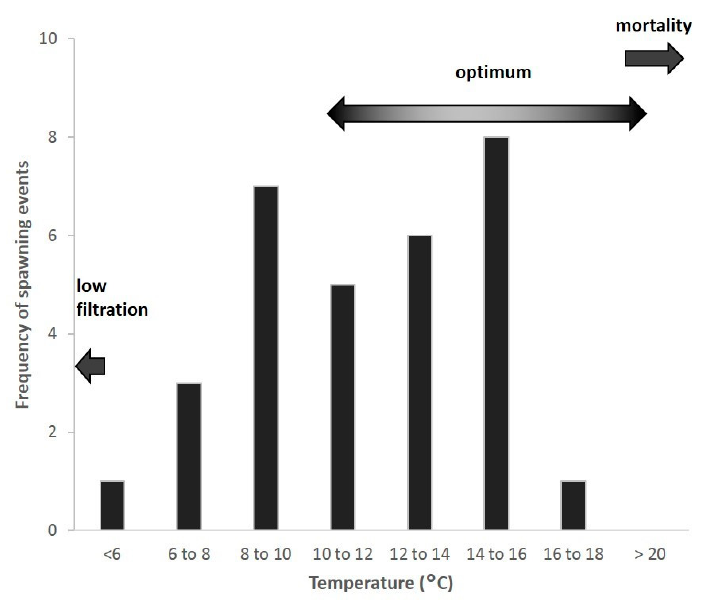
Figure 6. Frequency distribution of reported spawning events, and indication of optimal growth, lowered filtration rate, and mortalities at different temperature thresholds for the blue mussel Mytilus edulis , based on Table 1.